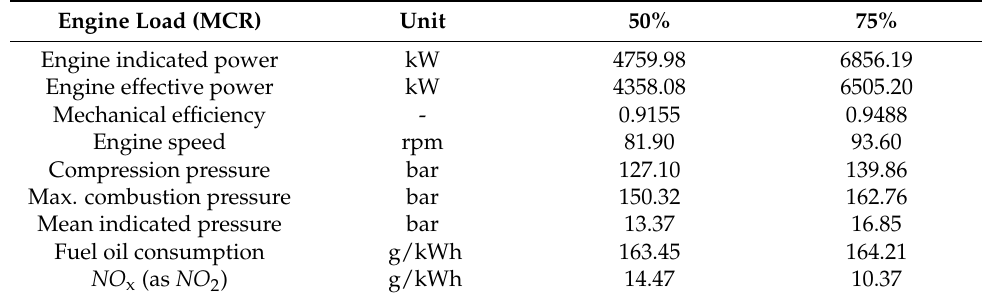
Table 6. Engine acceptance test